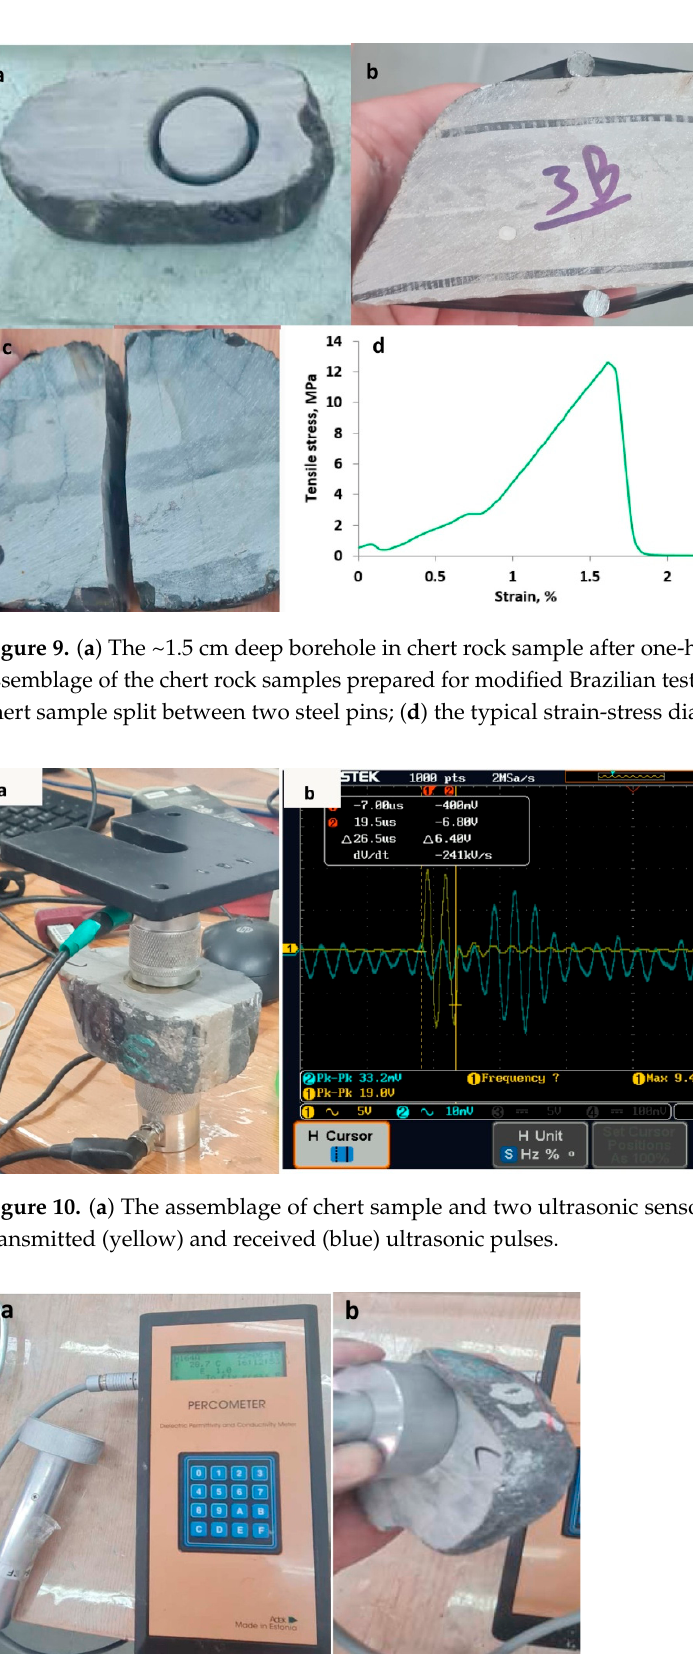
Figure 11. ( a ) The Percometer instrument; ( b ) the measurement of dielectric